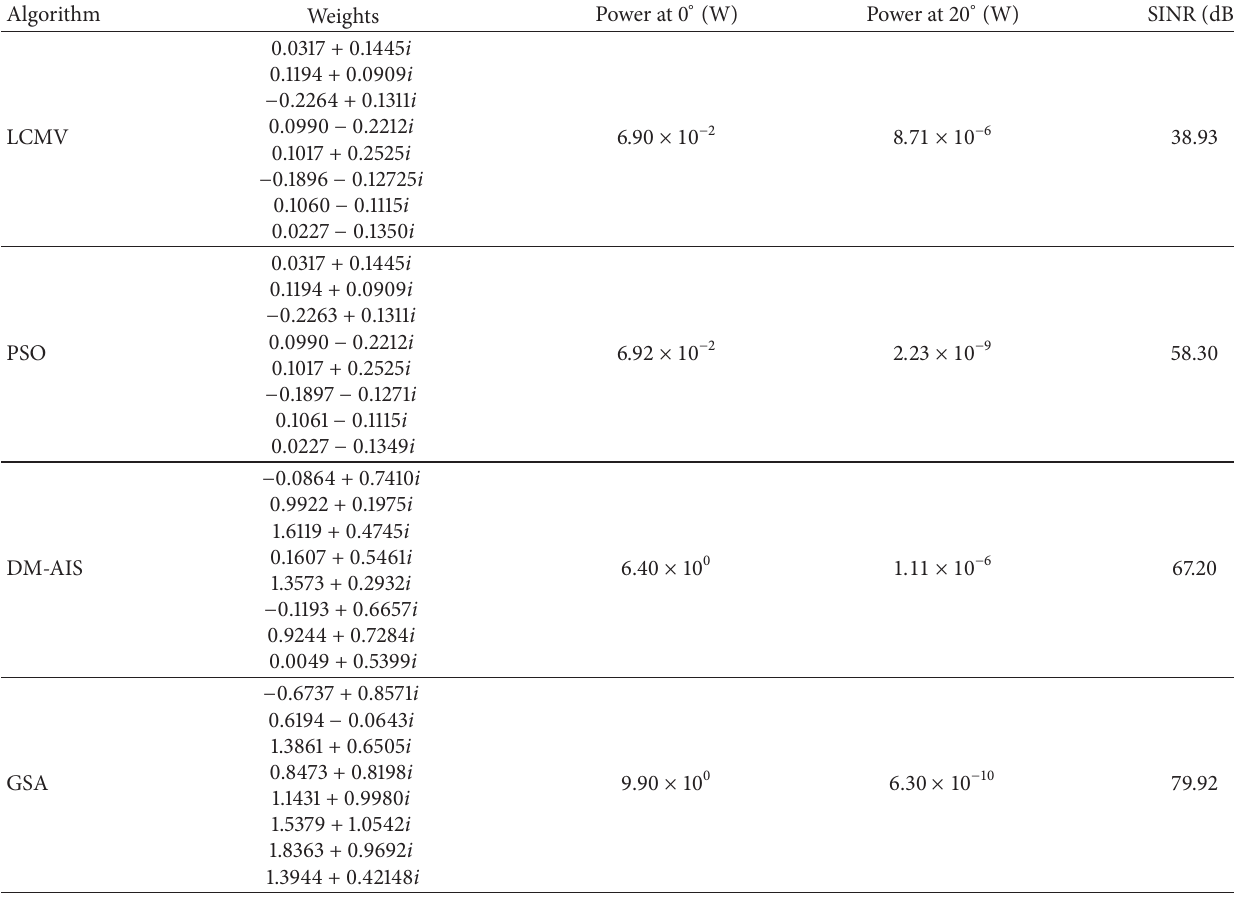
Table 4: Comparison of weight vectors, power values, and SINR calculation for conventional LCMV, PSO-LCMV, DM-AIS-LCMV, and GSA-LCMV for user at 0 ∘ with interference at 20 ∘ by using 8